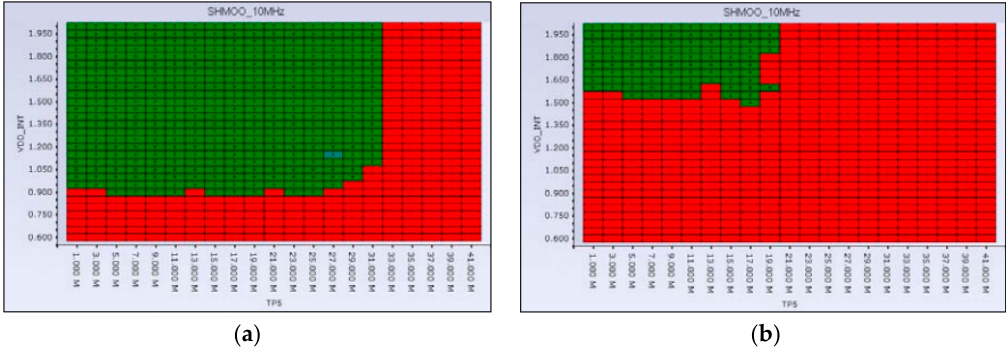
Figure 14. ( a ) Shmoo plot for a good die. ( b ) Shmoo plot for a marginal-voltage fail die. Marginal failure is common in which the failure is dependent on voltage or timing.